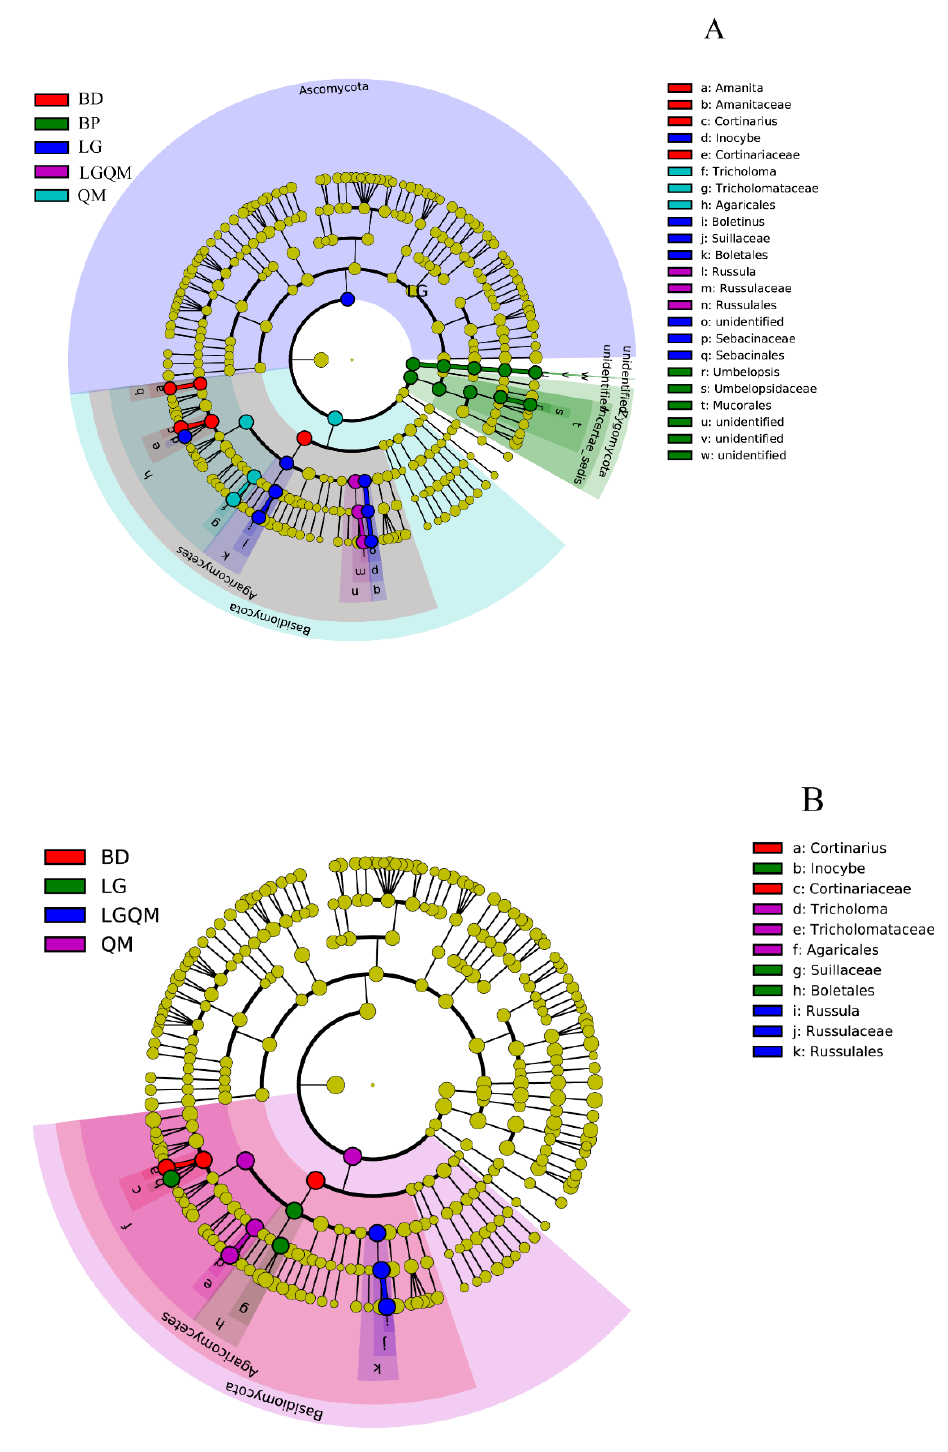
Figure 8. Cladogram of the fungal communities in the five types of forest soils with LDA > 4.5 ( A ) and >5.0 ( B ). The circles represent fungal taxa from phylum to genus starting from the center. BD, Betula dahurica ; BP, Betula platyphylla ; LG, Larix gmelinii ; LGQM, Q. mongolica and L. gmelinii mixed forest; QM, Quercus mongolica .